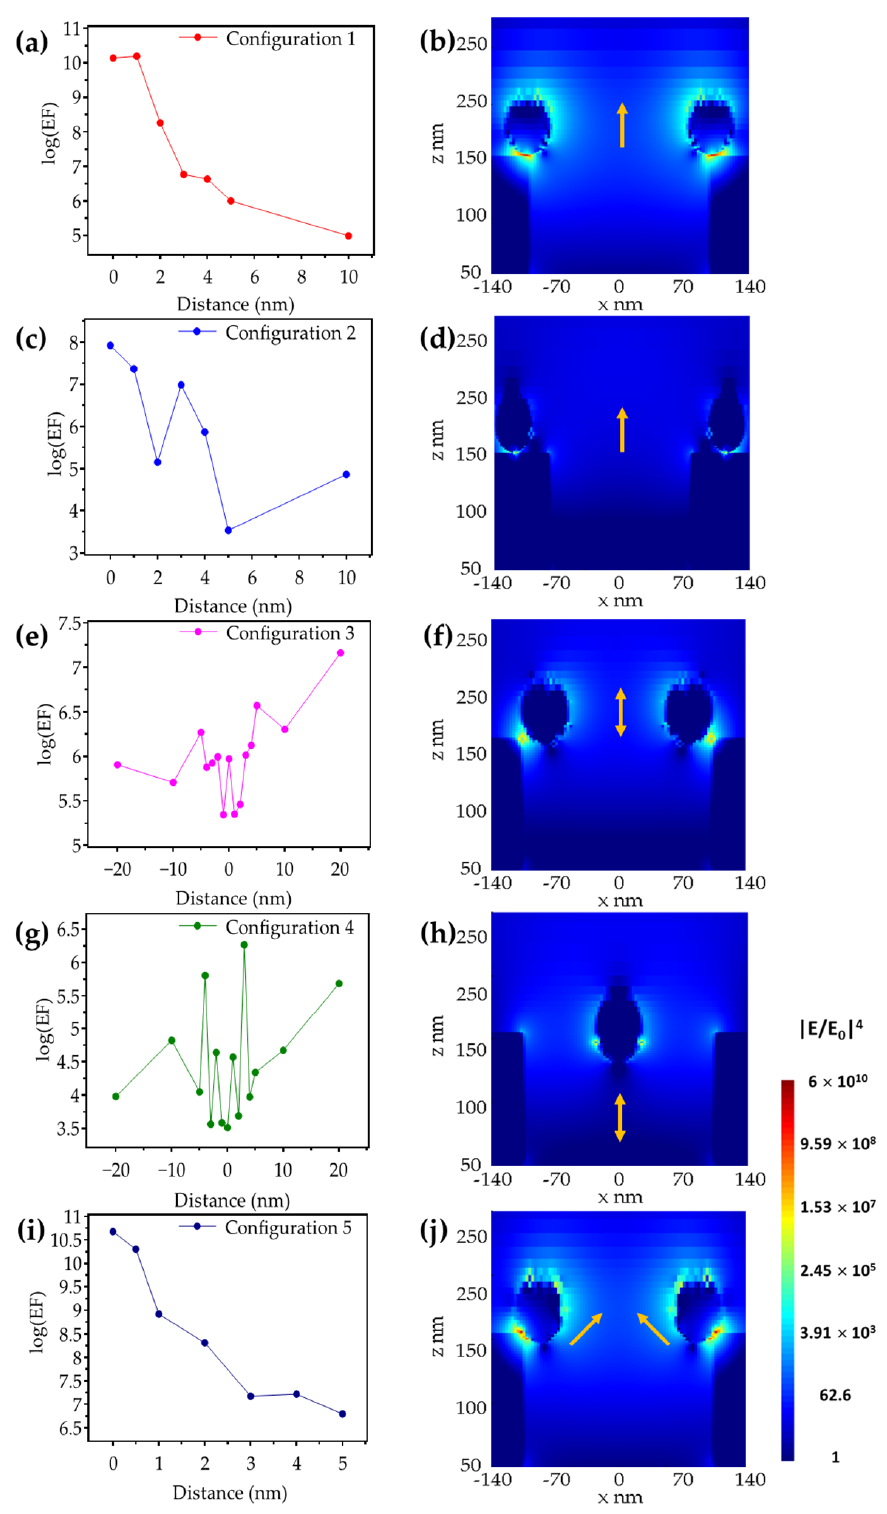
Figure 5. Ag-NP-on-Au-NHA G SERS values for different distances (left column) and e-field distributions (| E / E 0 | 4 ) of the electromagnetic Raman enhancement factor for the position with the highest G SERS (right column) for ( a , b ) Configuration 1, ( c , d ) Configuration 2, ( e , f ) Configuration 3, ( g , h ) Configuration 4, and ( i , j ) Configuration 5. Yellow arrows indicate the direction in which the particles are displaced.